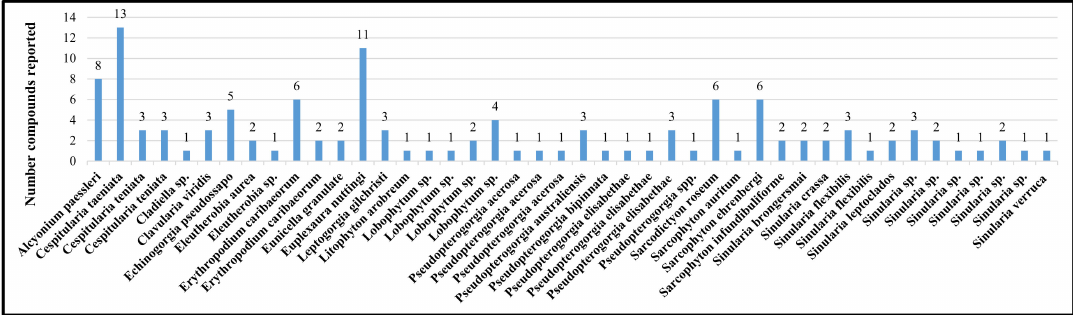
Figure 11. Distribution of Nitrogen containing metabolites between Alcyonacea species.